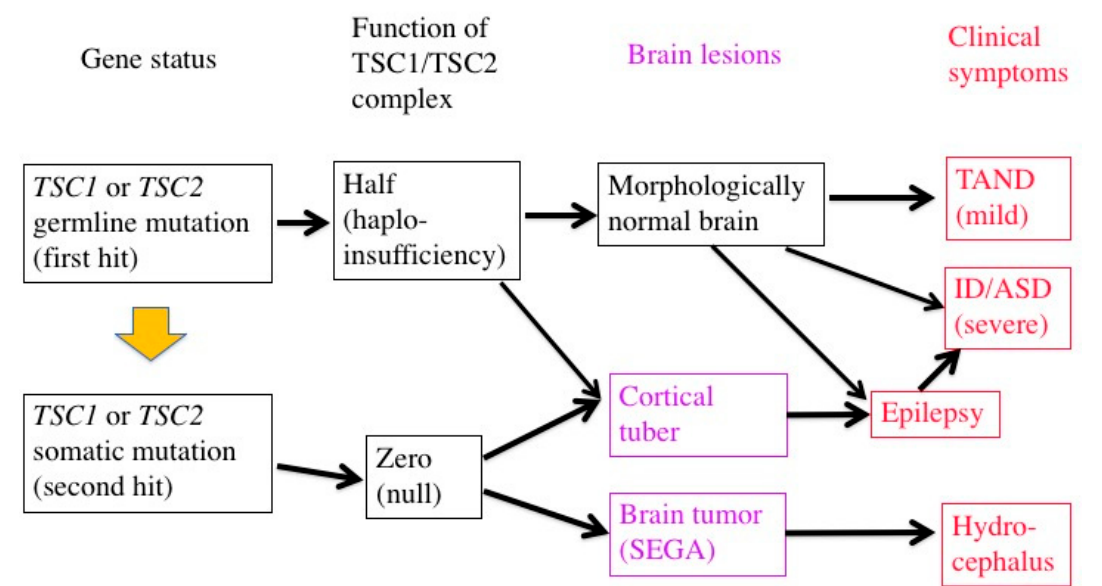
Figure 2. Two-hit hypothesis in a brain with TSC. The first hit, or germline mutation, can cause, by itself, mild TAND symptoms without any morphologic abnormalities. The second hit, or somatic mutation, may produce morphologic lesions (purple), either hamartoma (SEGA) or hamartia (cortical tuber). A tuber consists of a large number of “haploinsufficient” neurons and glial cells of normal size, and a small number of “null” cells of abnormal size and shape, and may become the focus of epileptic discharge. Severe early-onset epilepsy distorts the development of the brain network, leading to severe ID and/or